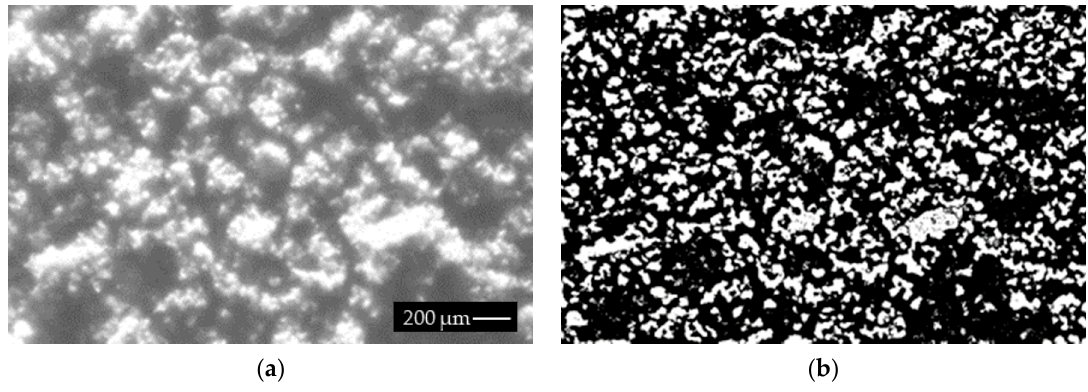
Figure 15. The acquired images of mixed granularities ( a ), results of the proposed method ( b ).